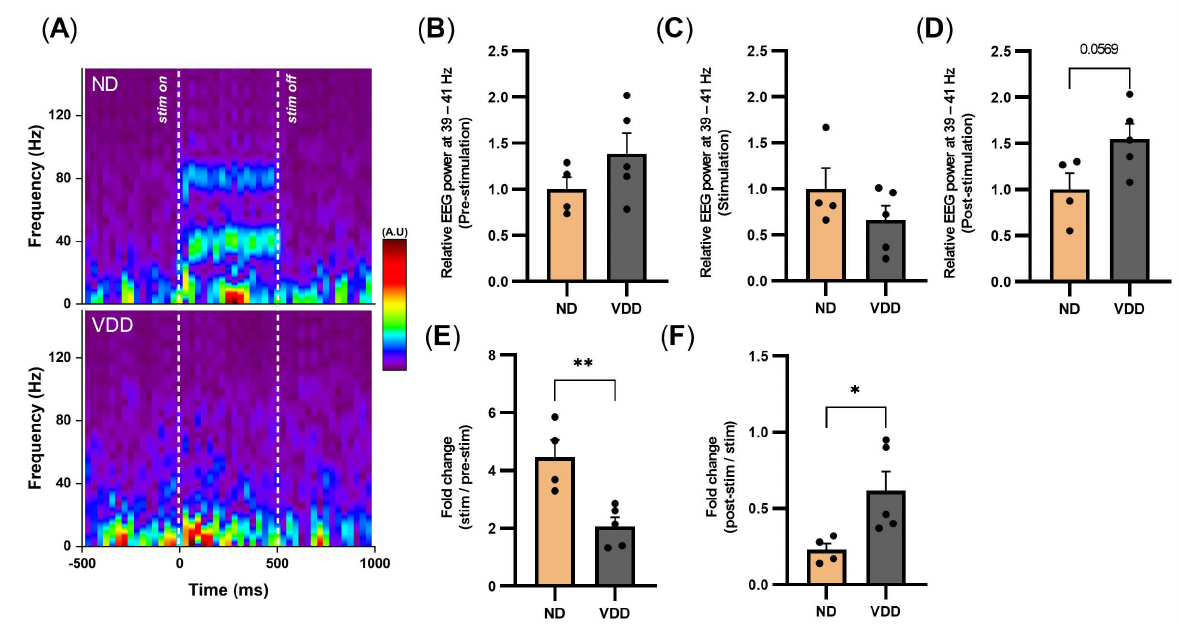
Figure 3. Auditory-evoked GBO reduced by vitamin D deficiency. ( A ) Representative time-frequency spectrogram of frontal electroencephalogram (EEG) from the normal and vitamin D-deficient diet at 20 weeks (normal diet, top; vitamin D-deficient diet, bottom). ( B – D ) Relative EEG power at 40 ± 1 Hz during the pre-stimulation, stimulation, and post-stimulation periods, respectively. ( E ) Fold change during the stimulation period in comparison with the pre-stimulation period. ( F ) Fold change during the post-stimulation period in comparison with the stimulation period. Data are presented as mean ± SEM.